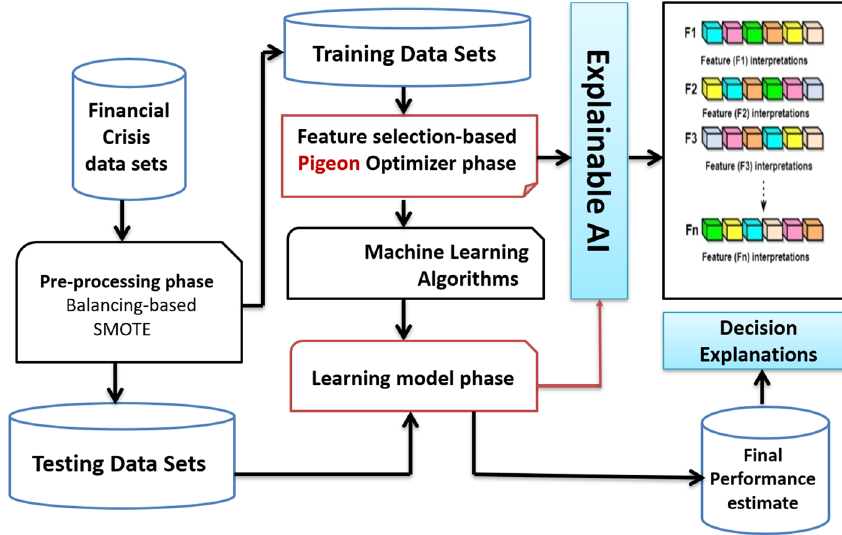
Fig. 2 The general architecture of the proposed financial crisis roots recognition